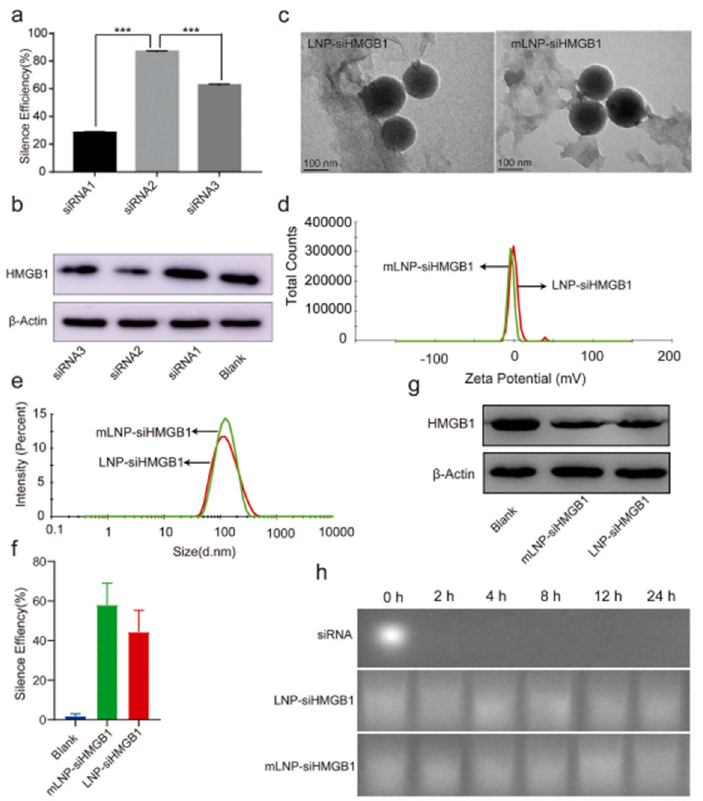
Figure 8. siRNA sequences screening and characterization of mLNP-siHMGB1. ( a ) Gene silencing efficiency (QPCR) of three siRNA sequences. More than 80% of silencing efficiency was achieved by the second siRNAi. *** represent p < 0.001. ( b ) Western blot image displaying the effect of three different siRNA sequences on the HMGB1 protein expression; suggesting that siRNA2 sequences significantly decreased the HMGB1 protein expression. ( c ) TEM images suggested the spheroidal structures of LNP-siHMGB1 and mLNP-siHMGB1. ( d ) Zeta potential is nearly 0 mV. ( e ) Mean particle size was around 100 nm, with <0.2 polydispersity index (PDI), ( f ) LNP-siHMGB1 and MLNP-siHMGB1silencing efficiency. ( g ) HMGB1 protein expression was reduced by LNP-siHMGB1 and mLNP-siHMGB1 treatment as indicated by Western blot analysis, and ( h ) The LNP or mLNP encapsulating the siHMGB1 did not deteriorate within 24 h in the serum, indicating good serum stability. Adapted with permission from Ref. [174], J. Control. Release